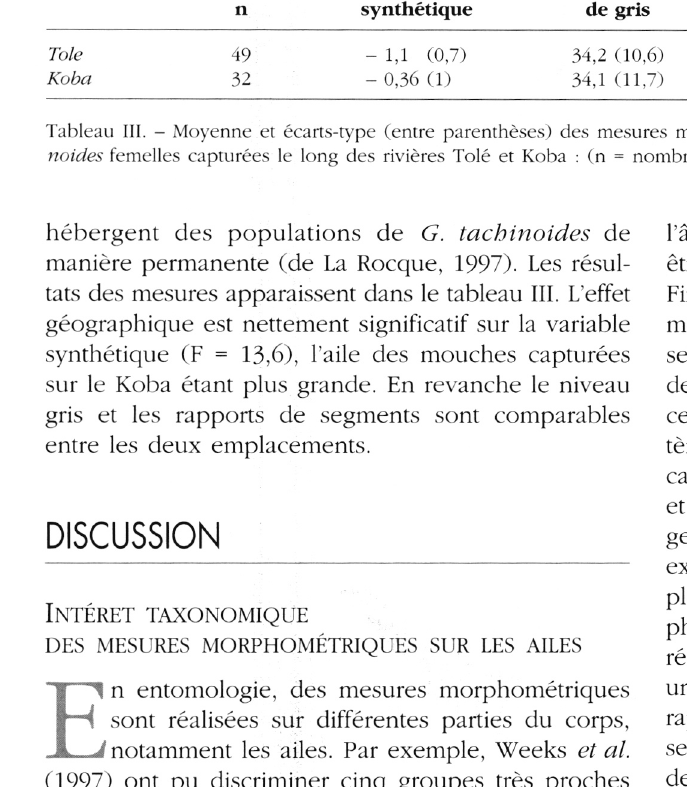
Tableau III. - Moyenne et écarts-type (entre parenthèses) des mesures morphométriques obtenues avec des individus de Glossina tachi- noides femelles capturées le long des rivières Tolé et Koba : (n = nombre d’individus, surface en mm2, niveau de gris entre 0 et 255).